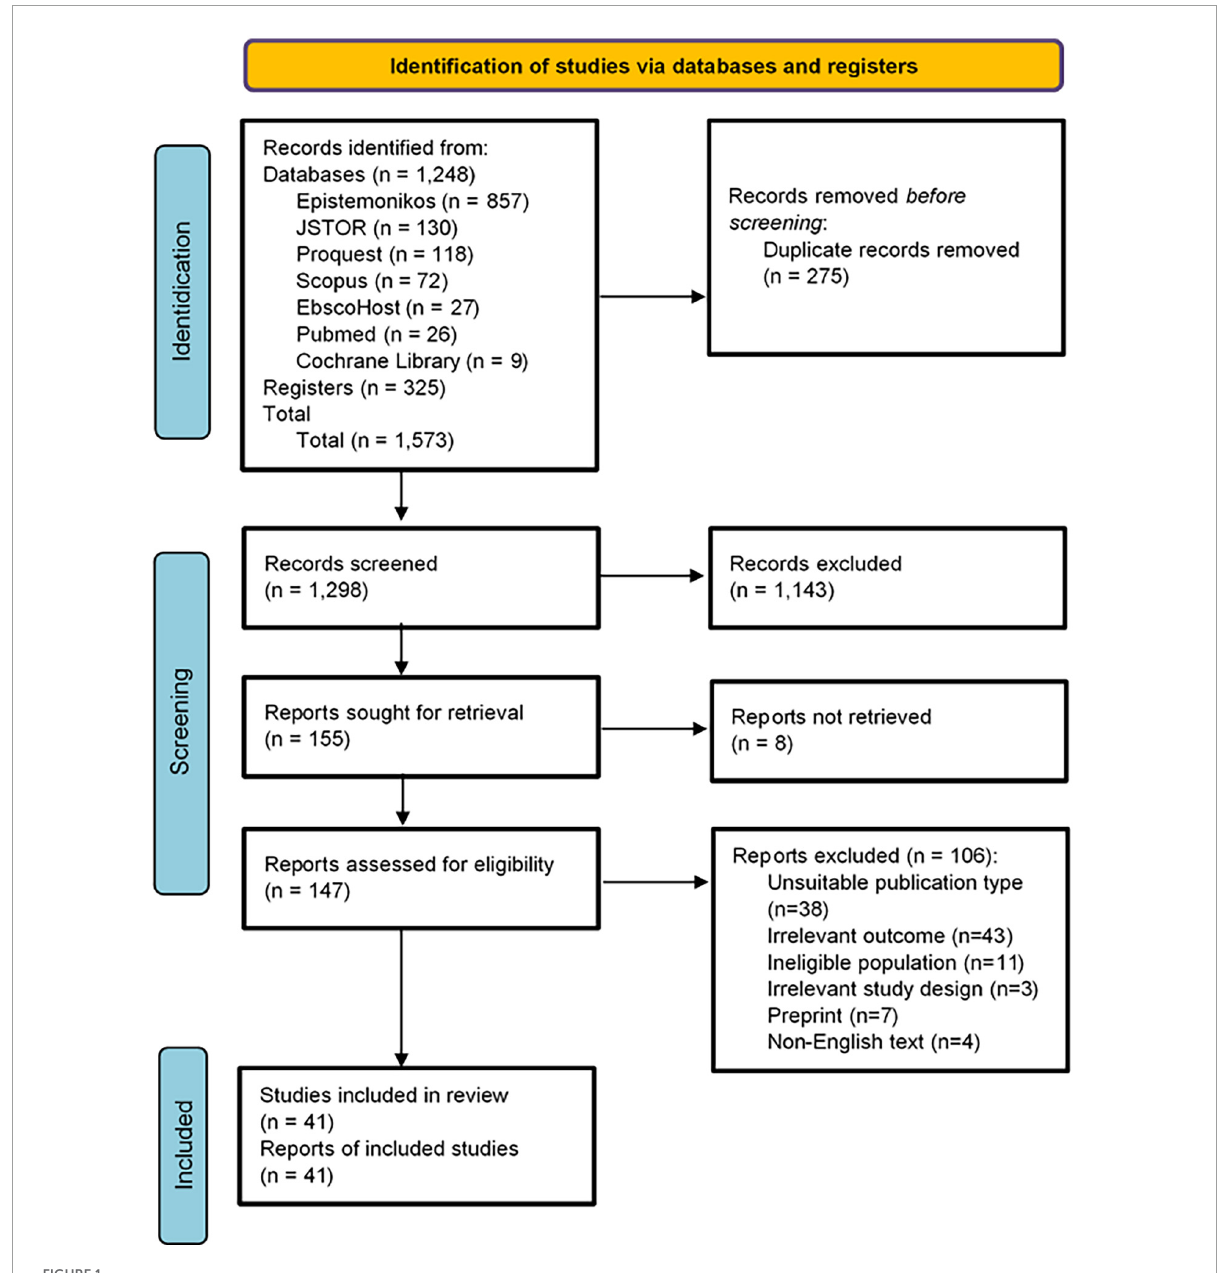
FIGURE1 PRISMA 2020 flow diagram of search and data